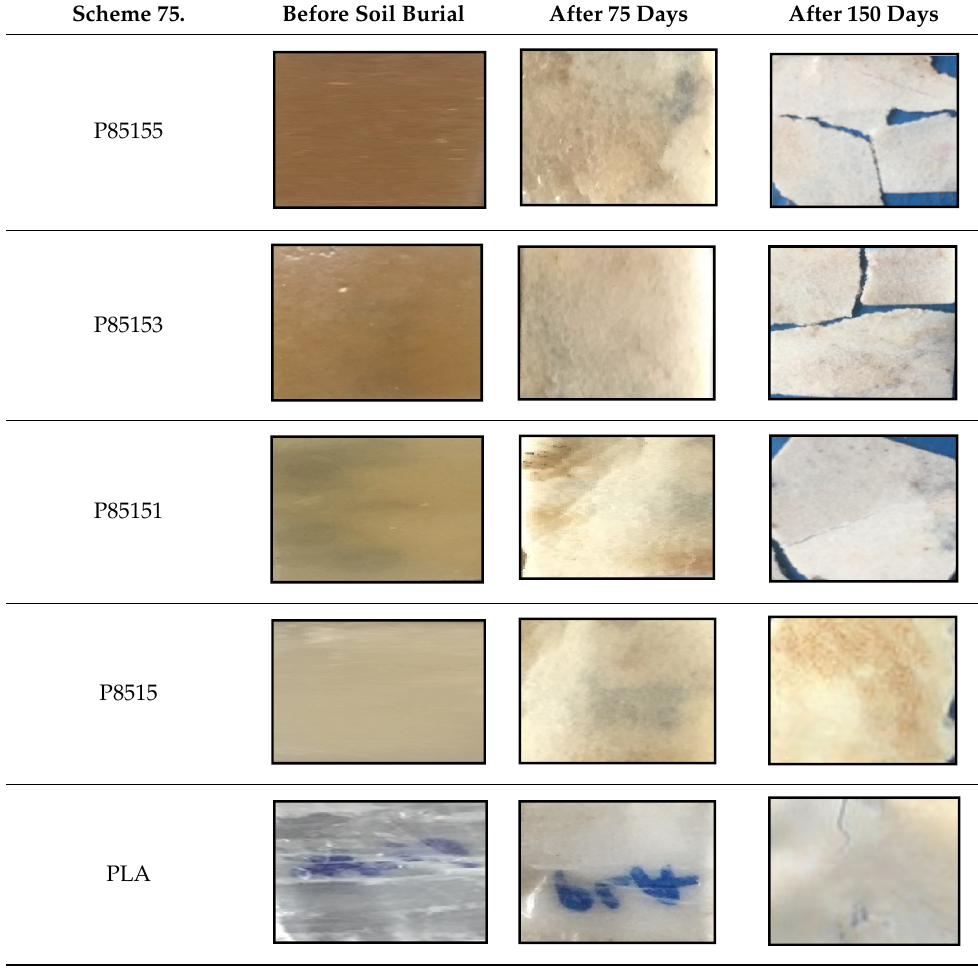
Table 1. Biodegradation sample result of neat PLA and biocomposites. Scheme 75.